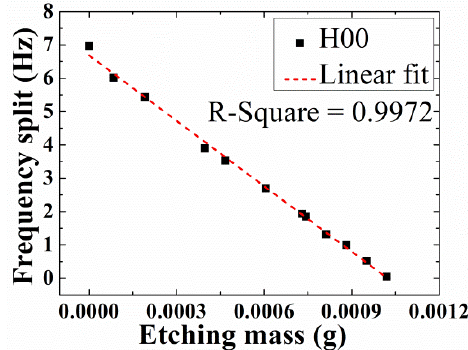
Figure 4. The frequency split of H00 change with etching mass.